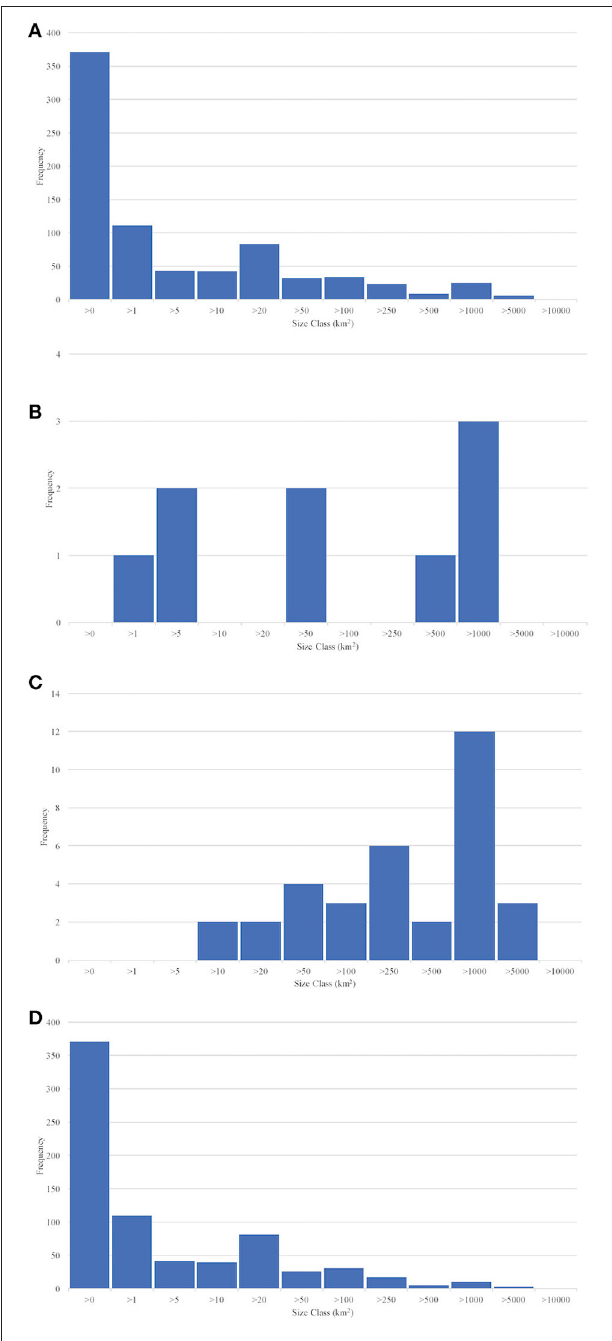
FIGURE 1 | Class-size frequency histograms for implemented MPAs in (A) North America, (B) Canada, (C) Mexico, and (D) USA. The scales shown on the y -axis differ.